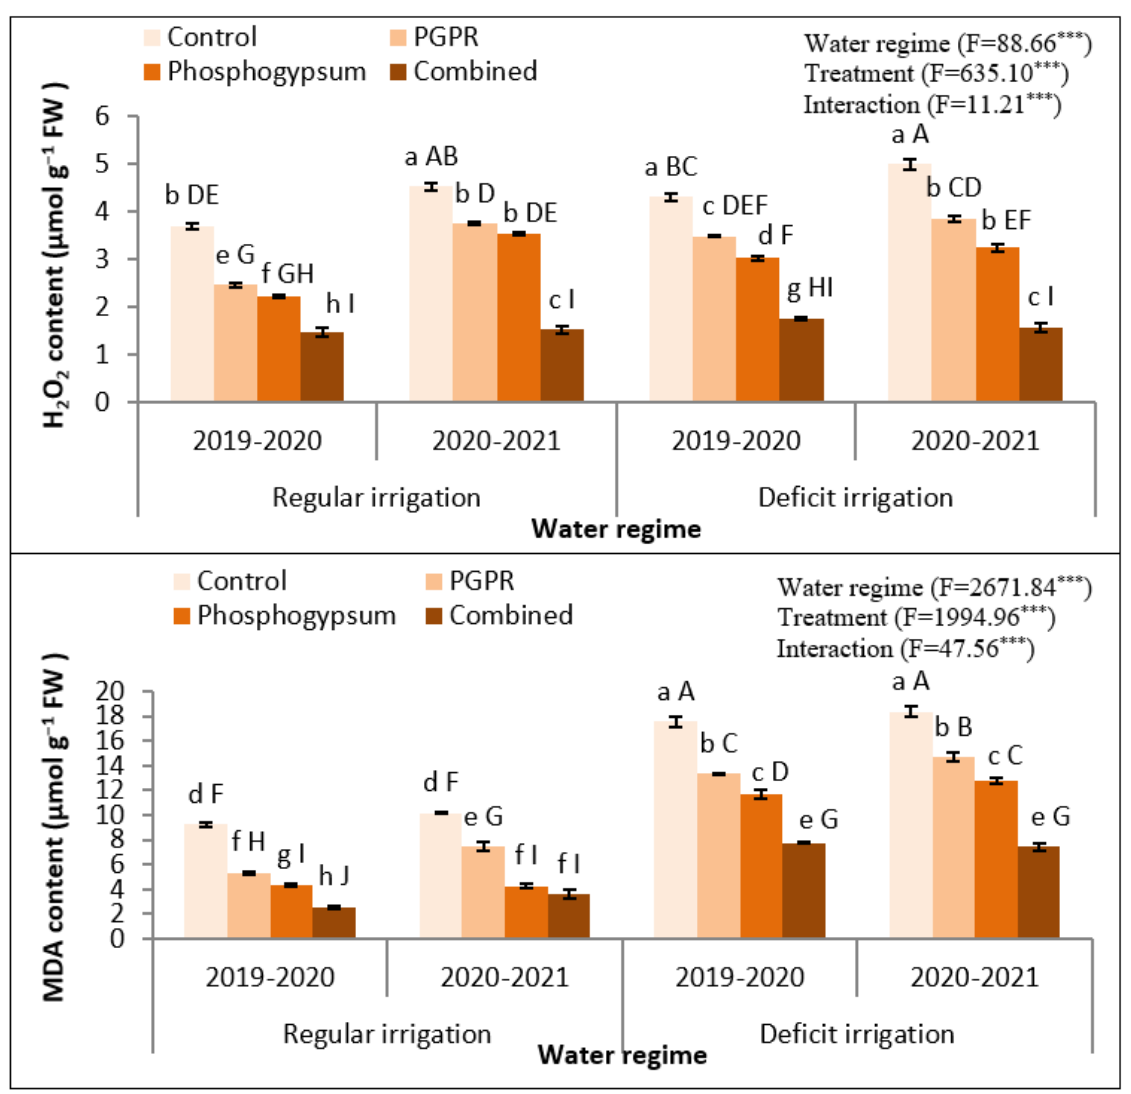
Figure 3. Response of hydrogen peroxide (H 2 O 2 ) and lipid peroxide (MDA) in quinoa (Chenopodium quinoa) to different water regimes in the presence of singular or dual application of PGPR and phosphogypsum during two growing seasons (2019–2020 and 2020–2021). Different lowercase letters on the same columns of the same season are significant according to the Tukey’s test ( p ≤ 0.05) and different uppercase letters are significant regardless of the growing season according to the Tukey’s test ( p ≤ 0.05). Data are Means ± SD and n = 3. *** denotes significance at p ≤ 0.001.